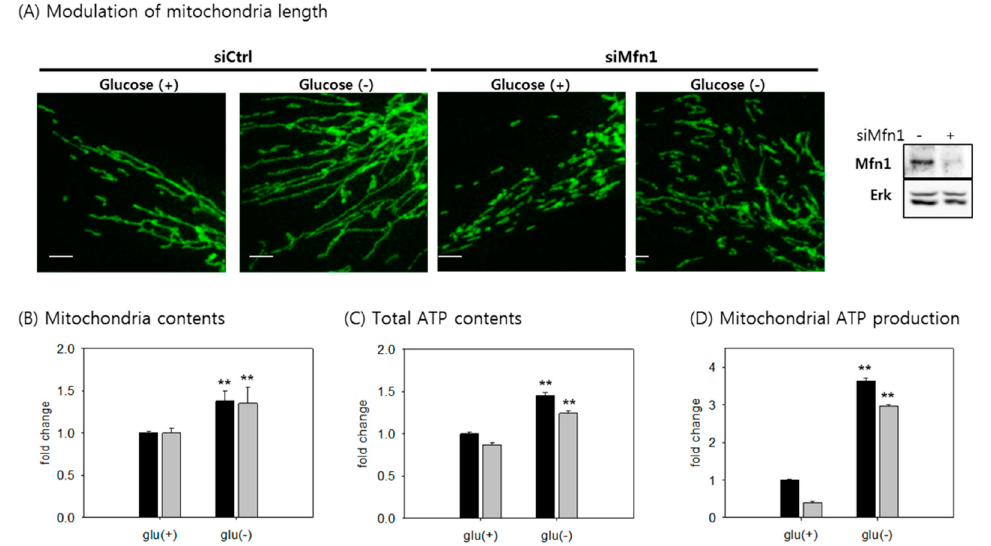
Figure 6. Elongation of mitochondria. ( A ) Fibroblasts cultured on a coverslip were deprived for the indicated time period and visualized by confocal microscopy. Mitochondria and autophagosomes were immunostained with antibodies against OXPHOS and LC3, respectively; ( B ) fibroblasts were glucose deprived for 1, 2, or 3 days, and subjected to immunoblot analysis with antibodies against Ser637 phospho-Drp1 or Drp1; ( C , D ) HCT116 or MCF7 cells were incubated in glucose-free medium for 36 h or 12 h. Mitochondria were immunostained with Tom20 antibody and observed by confocal microscopy. Lengths of mitochondria were measured and plotted by ImageJ analysis software. Lengths of mitochondria was measured in more than 20 cells and plotted by ImageJ analysis software. All scale bars in microscopy indicate 5 μ m. Values are presented as mean ± s.d.; * p < 0.05, ** p < 0.01 by ANOVA.